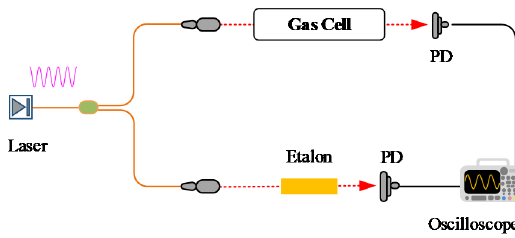
Figure 1. Experimental setup used for the validation of the proposed wavelength modulation-direct absorption spectroscopy (WM-DAS) method.